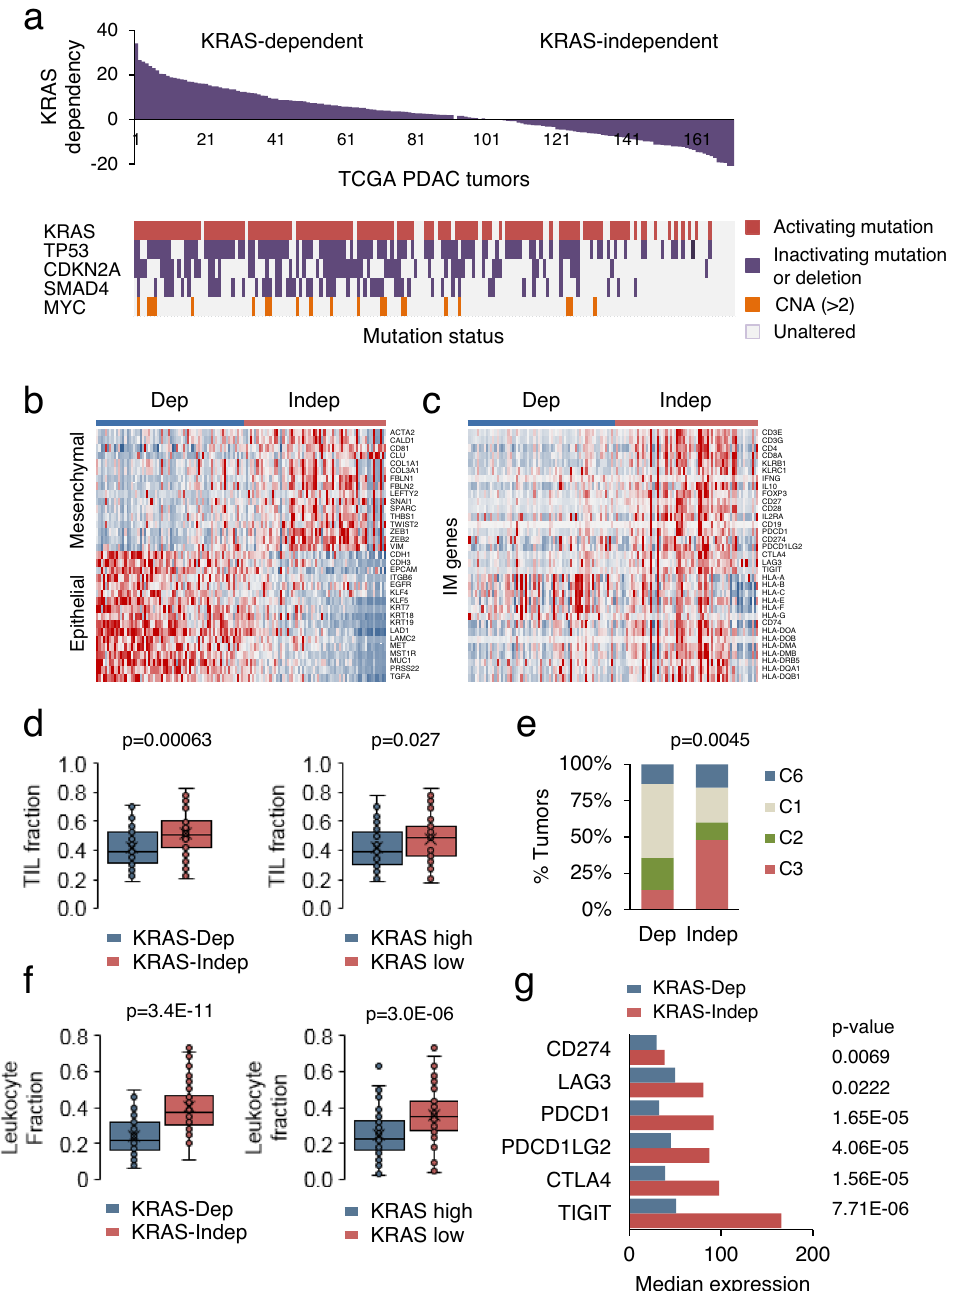
Fig. 4 Immunomodulatory effects of mutant KRAS in human PDAC. a Human PDAC samples ( n = 178) derived from the TCGA database were divided into two groups according to a gene expression signature (KRAS-dependency index, RDI) that distinguishes putative KRAS-dependent (RDI > 4) and -independent cell states (RDI < 0) (top). Landscape of genomic alterations in the human PDAC tumors is shown (bottom). b , c Heatmaps derived from data in ( a ) depicting differentially expressed genes in KRAS-dependent tumors ( n = 69) versus distinctive KRAS-independent tumors ( n = 65). d Box plots showing TIL fraction in KRAS-dependent ( n = 60) versus KRAS-independent tumors ( n = 50), and KRAS-high ( n = 60) versus KRAS-low tumors ( n = 50) in the digital-pathology PDAC database 40 . Box plots show center line as median, box limits as upper and lower quartiles, and whiskers represent a 1.5× interquartile range. Signi fi cance was determined using two-tailed t -test at the 0.05 con fi dence interval. e Distribution of immune subtypes within KRAS- dependent ( n = 60) and KRAS-independent tumors ( n = 50): C1 (wound healing), C2 (IFNG dominant), C3 (in fl ammatory), and C6 (TGF-beta dominant). The proportion of samples belonging to each immune subtype is shown. Signi fi cance was determined using two-sided Fisher ’ s exact test. f Box plots showing leukocyte fraction in KRAS-dependent ( n = 68) versus KRAS-independent tumors ( n = 52), and KRAS-high ( n = 68) versus KRAS-low tumors ( n = 52) in the immune PDAC database 34 . Box plots show center line as median, box limits as upper and lower quartiles, and whiskers represent a 1.5× interquartile range. Signi fi cance was determined using two-tailed t -test at the 0.05 con fi dence interval. g Differential expression of immune checkpoint genes in KRAS-dependent ( n = 68) and KRAS-independent tumors ( n = 52). Signi fi cance was determined using two-tailed t -test at the 0.05 con fi dence interval. Tumors from b , c for which the immune information is available are considered in panels ( d – g ). Source data are available as a Source data fi